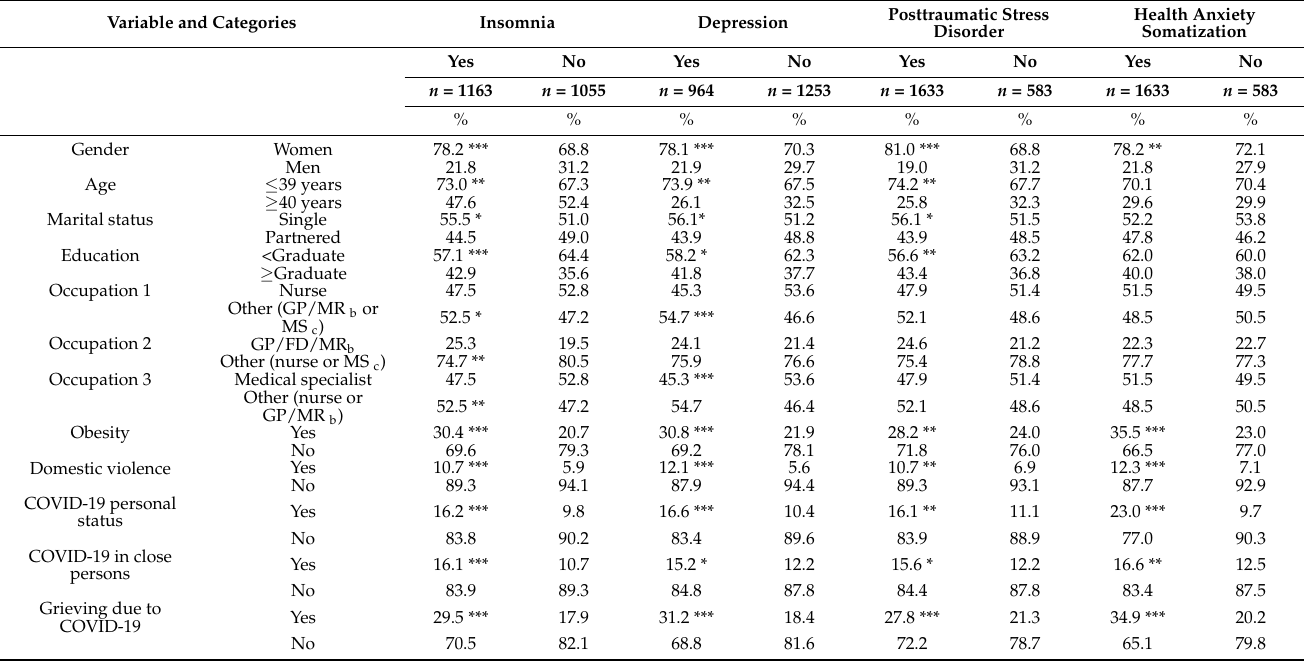
Table 3. FHCW during COVID-19 peak: Bivariate comparisons by main MHP a ( n =